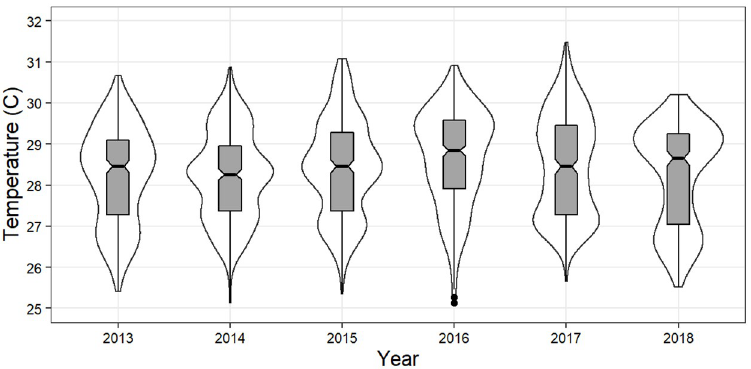
Fig 5. Summary of temperature data in form of a violin plot of daily average temperature by year with inset box plots. Outer lines depict distribution of observations within the sample year. Box plots depict the standard quartiles and data